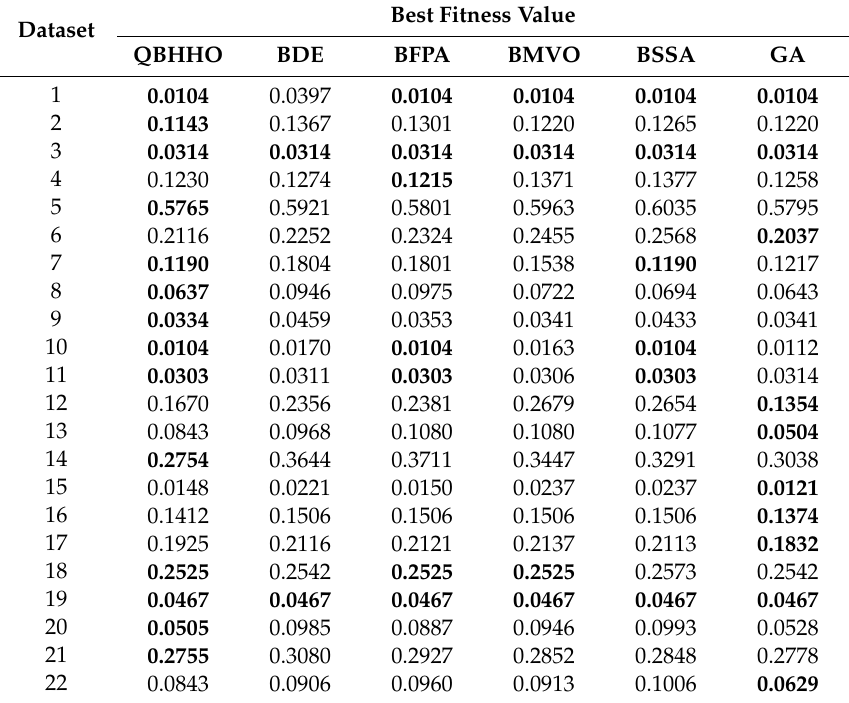
Table 10. Experimental result of the best fitness value of six di ff erent algorithms.